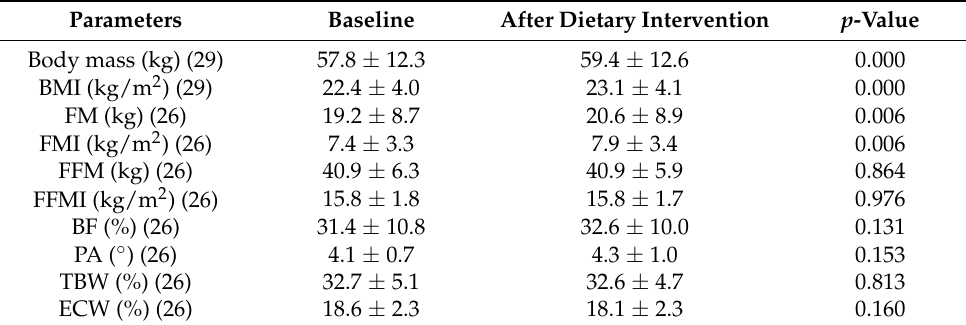
Table 5. Changes in body mass and body composition among elderly individuals at baseline and after dietary